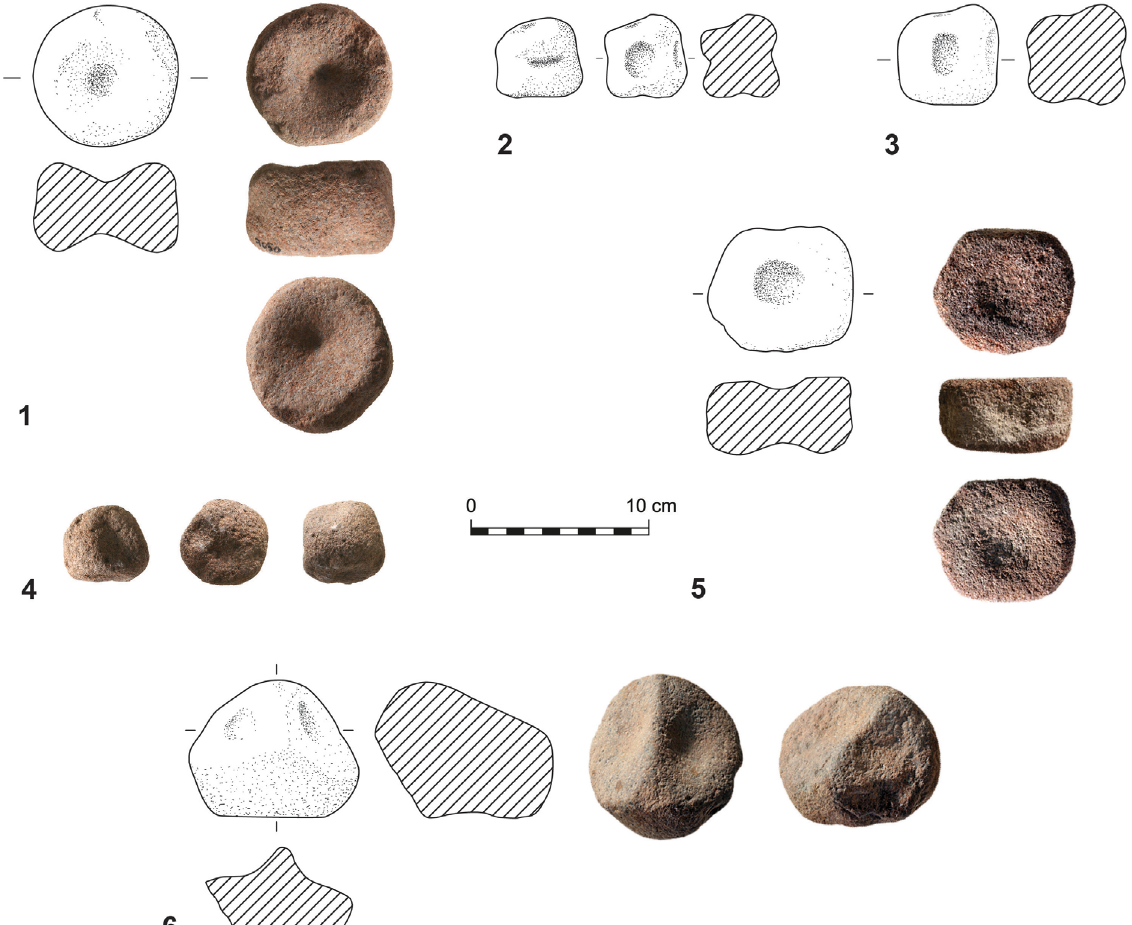
Figure 9. Pounders from Site 34. (1) B.7050 (survey): granite discoid pounder with dimples on both sides; (2) B.5432 (L.410, Area G): dolomite pounder with dimples on all sides; (3) B.7318 (survey): granite pounder with dimples on all sides; (4) B.1 (survey): granite pounder with dimples on all sides; (5) B.10 (survey): discoid compacted coarse sandstone pounder with dimples on both sides; (6) B.5818 (L.519, Area A): granite pounder with dimples on all